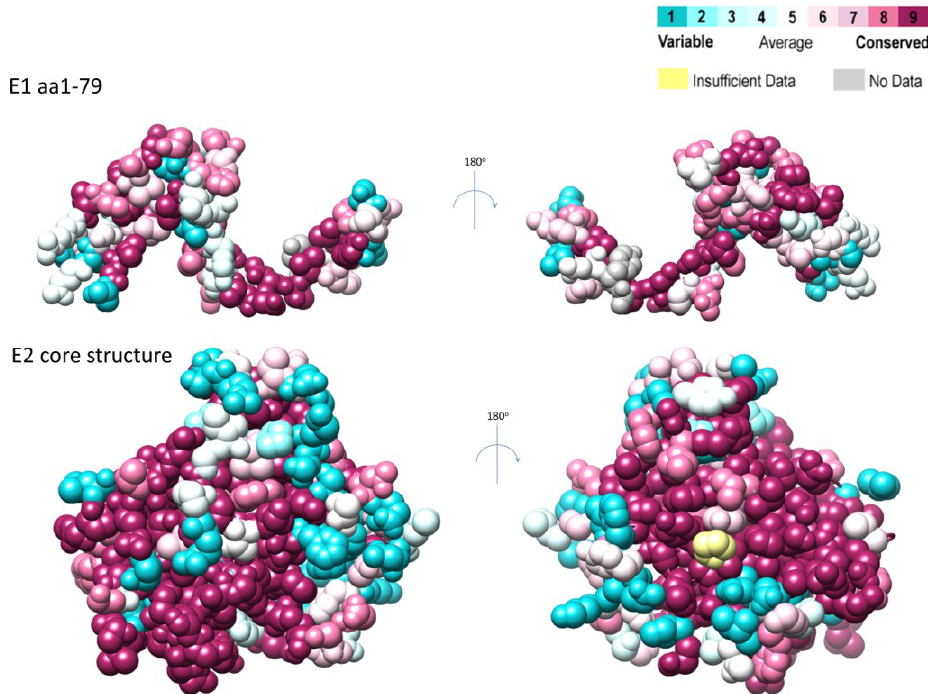
Figure 4. Conservation and variability in the E1 and E2 proteins. Conservation plots were generated using an alignment of 866 genotype 1 full-length E1E2 amino acid sequences retrieved from GenBank. Alignments were plotted using the ConSurf server [99], highlighting the variability in the first 79 amino acids of E1 (mapped onto pdb 4UOI), and the core structure of E2 (mapped onto pdb 4MWF). Conserved amino acids are represented in mauve, and highly variable amino acids in cyan. This analysis revealed a mainly conserved exposed face of the N-terminus of E1, with some variable residues buried in the monomer of the N-terminus of E1. It also showed two conserved faces of the core E2 structure (highlighted by contiguous mauve residues in the two diagrams), with a variable discontinuous region (highlighted with patches of cyan residues) surrounding the conserved CD81 binding residues and neutralizing epitopes.